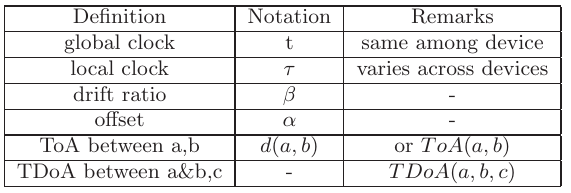
Table 1: Notations